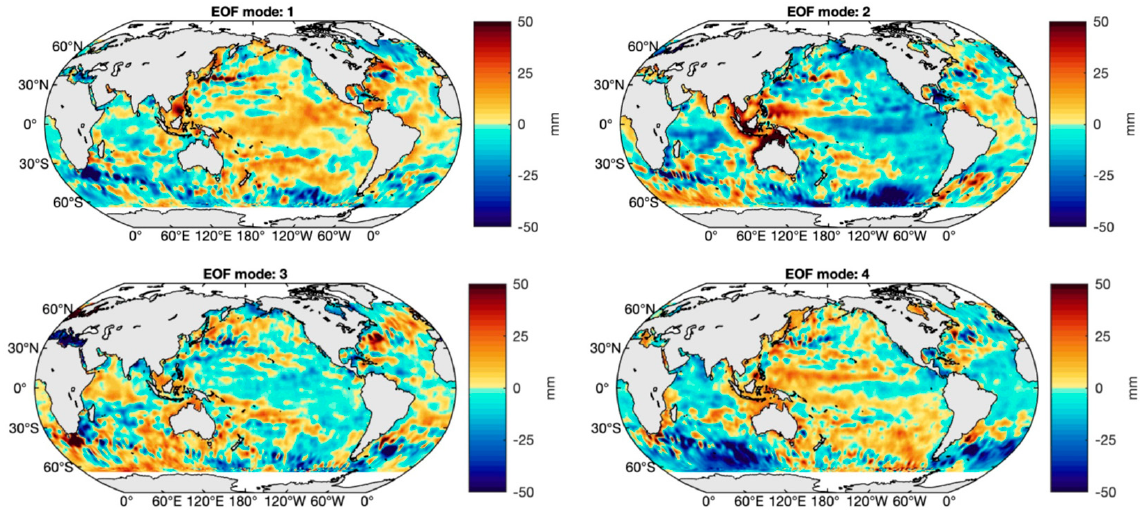
Figure 12. Modes 1, 2, 3 and 4 of the EOF decomposition of the steric-corrected altimetry-based C3S sea-level data for January 2005–December 2015.